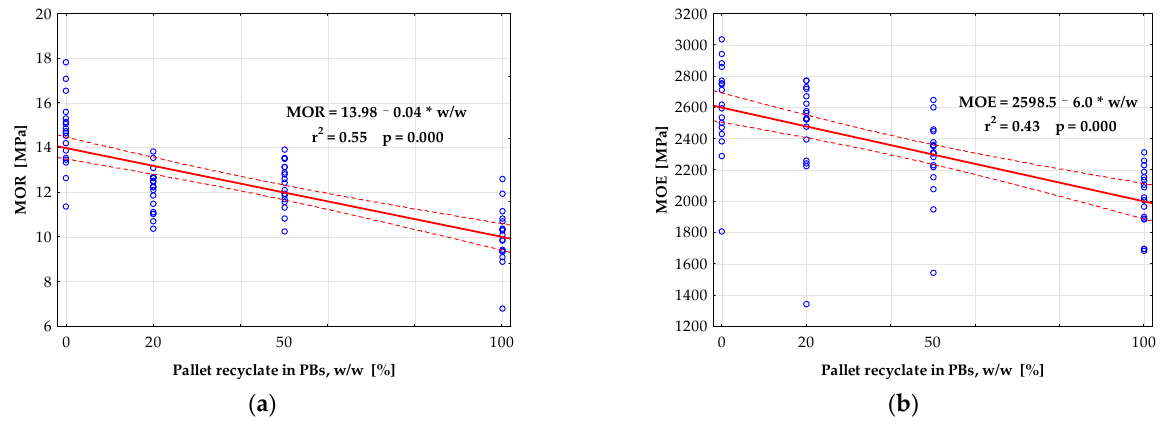
Figure 7. Modulus of rupture (MOR) ( a ) and modulus of elasticity (MOE) ( b ) of PBs containing particles from recycled spruce pallets (RSP).